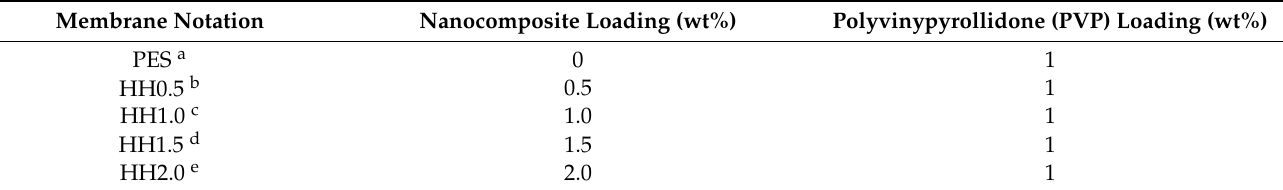
Table 1. Composition of nanocomposite loadings of differently modified membranes. Membrane